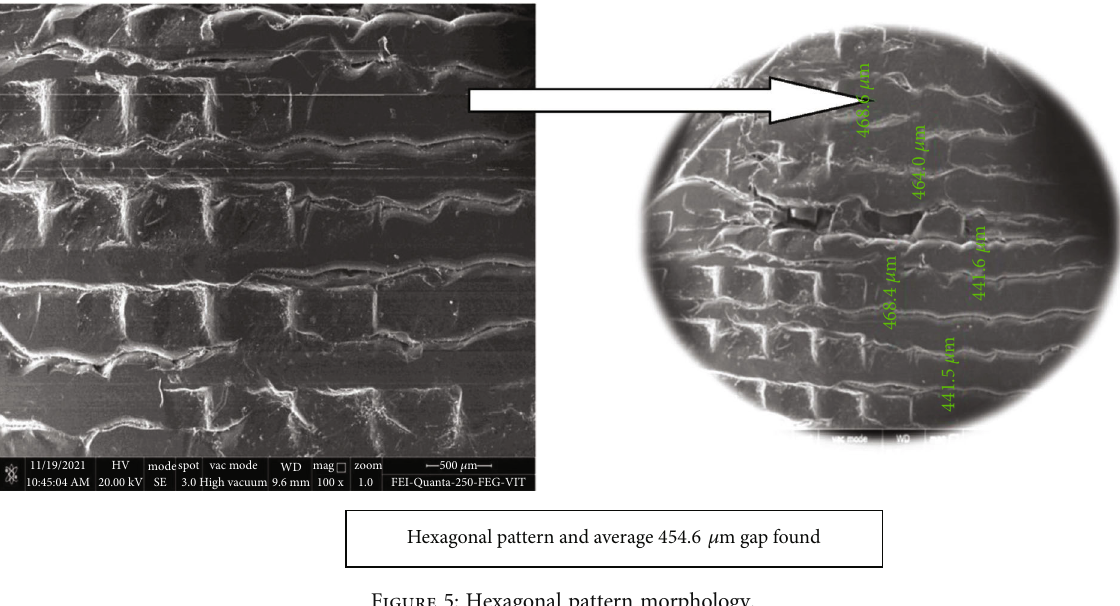
Figure 5: Hexagonal pattern morphology.